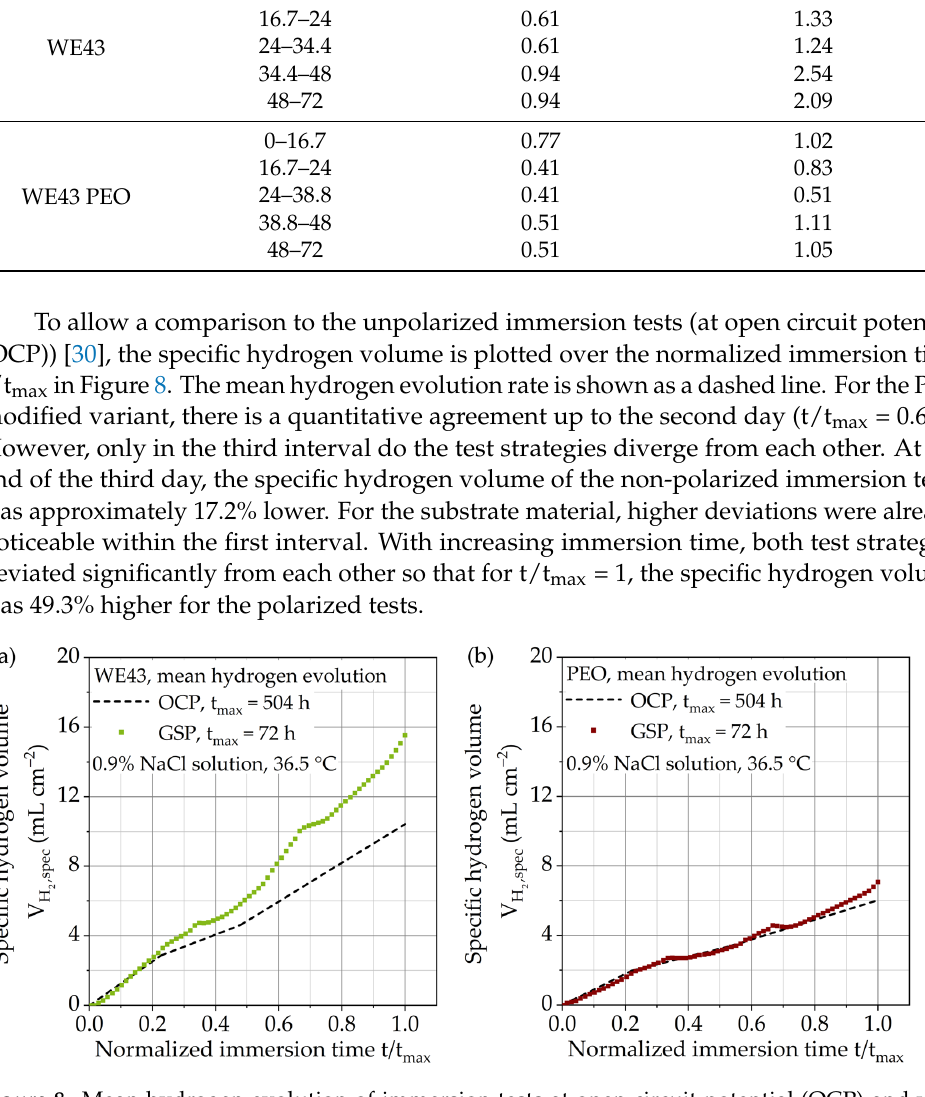
Figure 8. Mean hydrogen evolution of immersion tests at open circuit potential (OCP) and with galvanostatic polarization (GSP) in 0.9% NaCl solution at 36.5 °C: ( a ) WE43; ( b ) WE43 PEO.